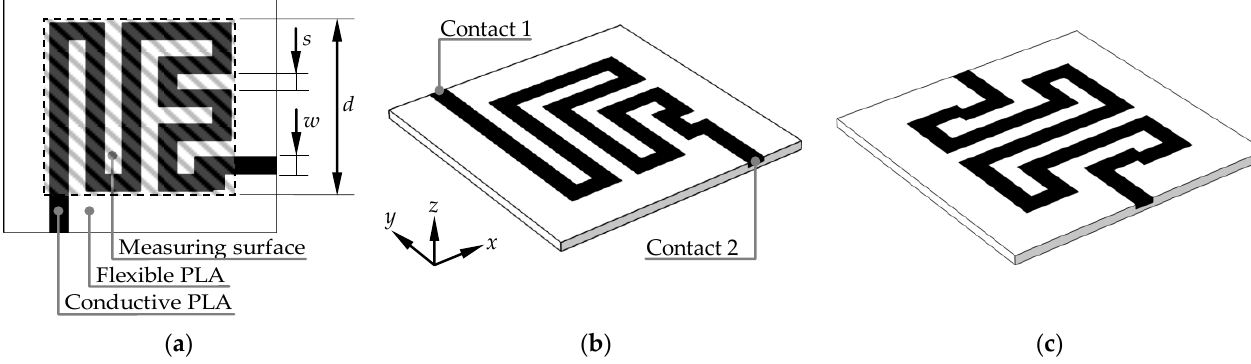
Figure 2. The proposed structures of surface temperature detectors: ( a ) composition of the structure with perpendicular contacts, ( b ) sensor with shifted parallel contacts and ( c ) sensor with centered parallel contacts.